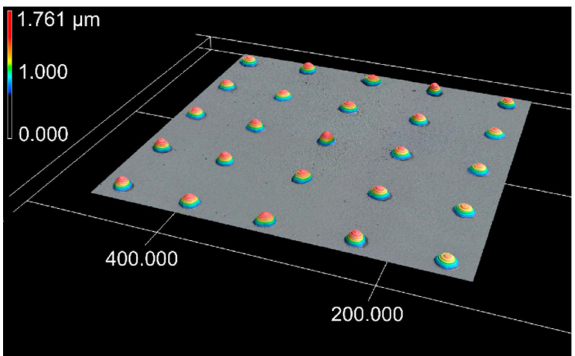
Figure 6. 3D-LSM image of a 5 × 5 array of ink droplets transferred by BA-LIFT onto a glass substrate. Z-axis is scaled by a factor of 10 compared to x and y axes. Process parameters: λ = 515 nm wavelength and E p = 1.75 µ J, gap between donor and receiver d G = 200 µ m, film thicknesses d D = 1.55 µ m liquid donor, and d PI = 3.5 µ m